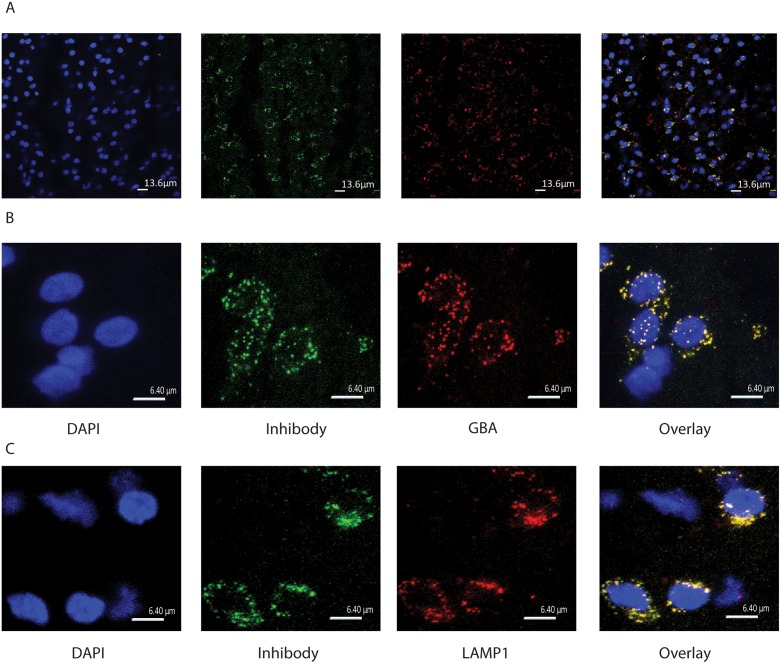
Cyclophellitol-epoxide ABP MDW933 administered i.c.v. labels specifically lysosomal GBA in the brain.(A) 63x Confocal images showing from left to right: DAPI stain, MDW933 (green Inhibody) labeling, GBA antibody labeling (red) and their overlay in the Po of the brainstem. (B) Zoom (3x) 63x confocal images showing clear colocalization. (C) Zoom (3x) 63x confocal images showing from left to right: DAPI stain, green MDW933, the lysosomal protein LAMP1 antibody labeling (red) and their overlay in the Po of the brainstem.